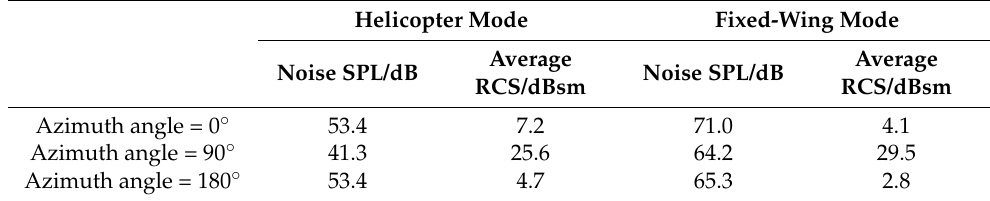
Table 22. Noise SPL and average RCS values with PPC3.